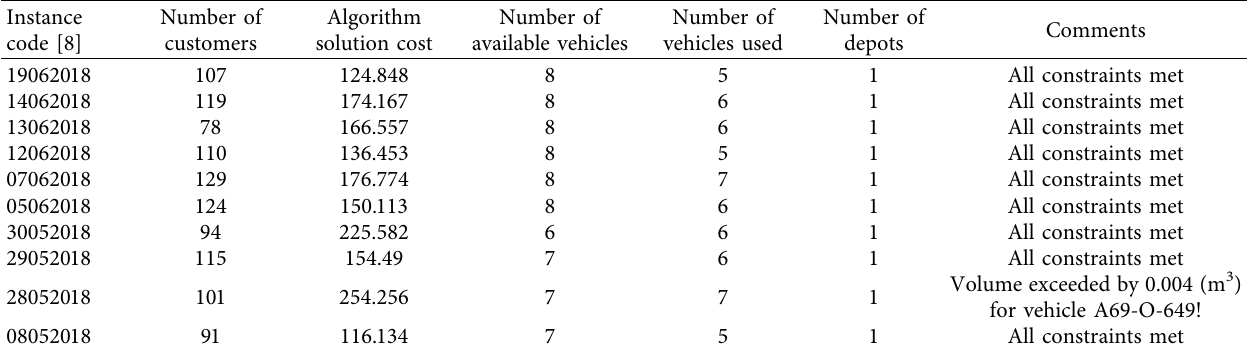
Table 3: Results of testing on real data of a distribution